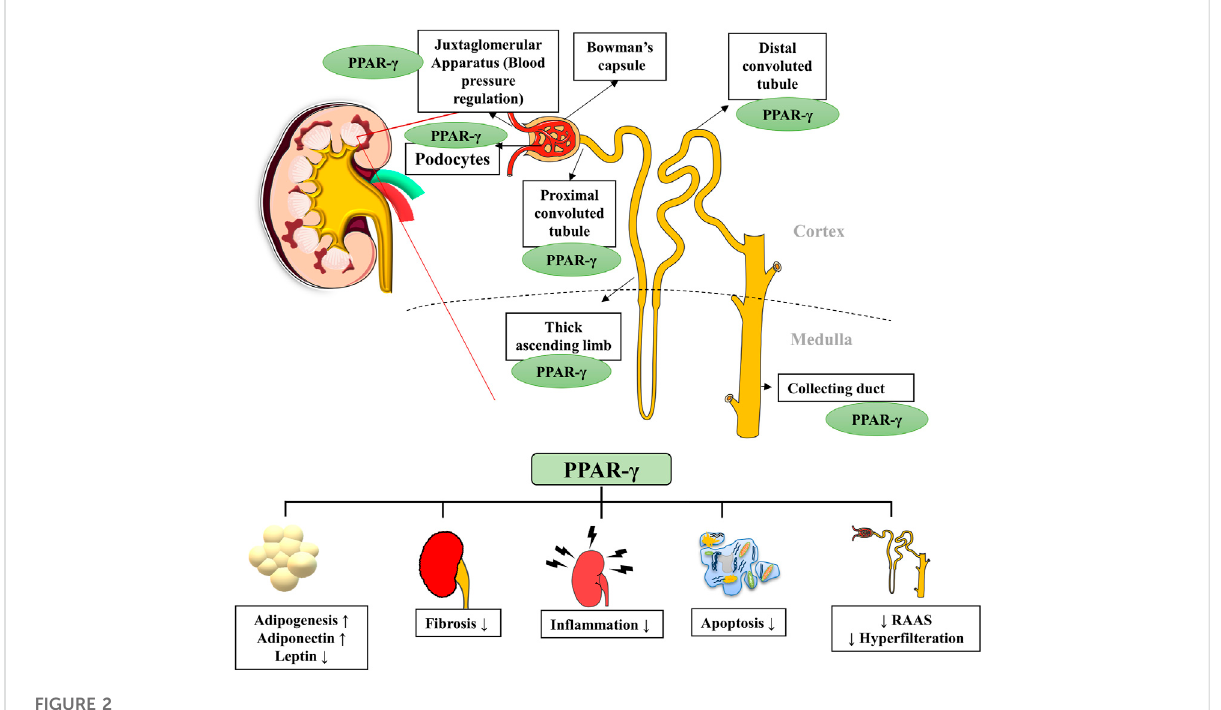
FIGURE 2 PPAR- γ presence in various parts of the nephron and its major functions. PPAR- γ is expressed in different parts of the nephron, such as bowman ’ s capsule, podocytes, proximal convoluted tubules, distal convoluted tubules and collecting ducts. PPAR- γ has a role in kidney in fl ammation, lipid metabolism, hypertension, fi brosis and apoptosis. RAAS, Renin-angiotensin-aldosterone